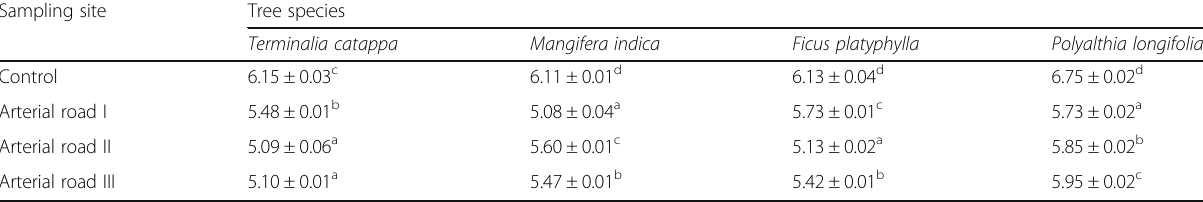
Table 5 The effect of vehicular air pollution on leaf extracts pH of selected tree species in the Kumasi Metropolis Sampling site